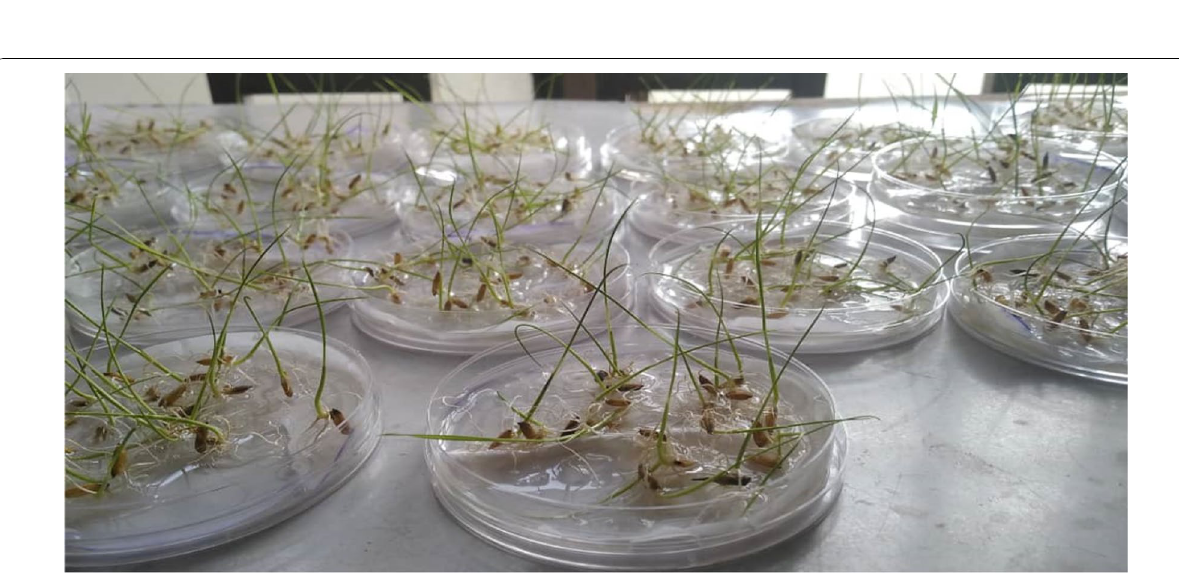
Fig. 12 In vitro growth of rice after inoculation with the three PSBs at 5DAS. DAS sp ., D Control. =